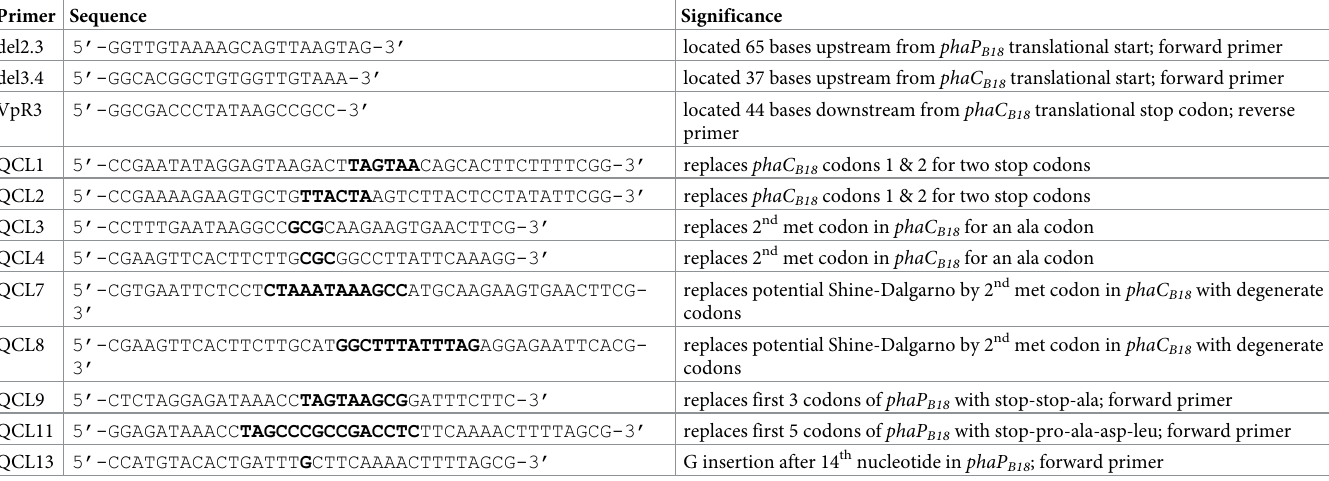
Table 2. Primers used to construct plasmids containing B-18 genes by PCR